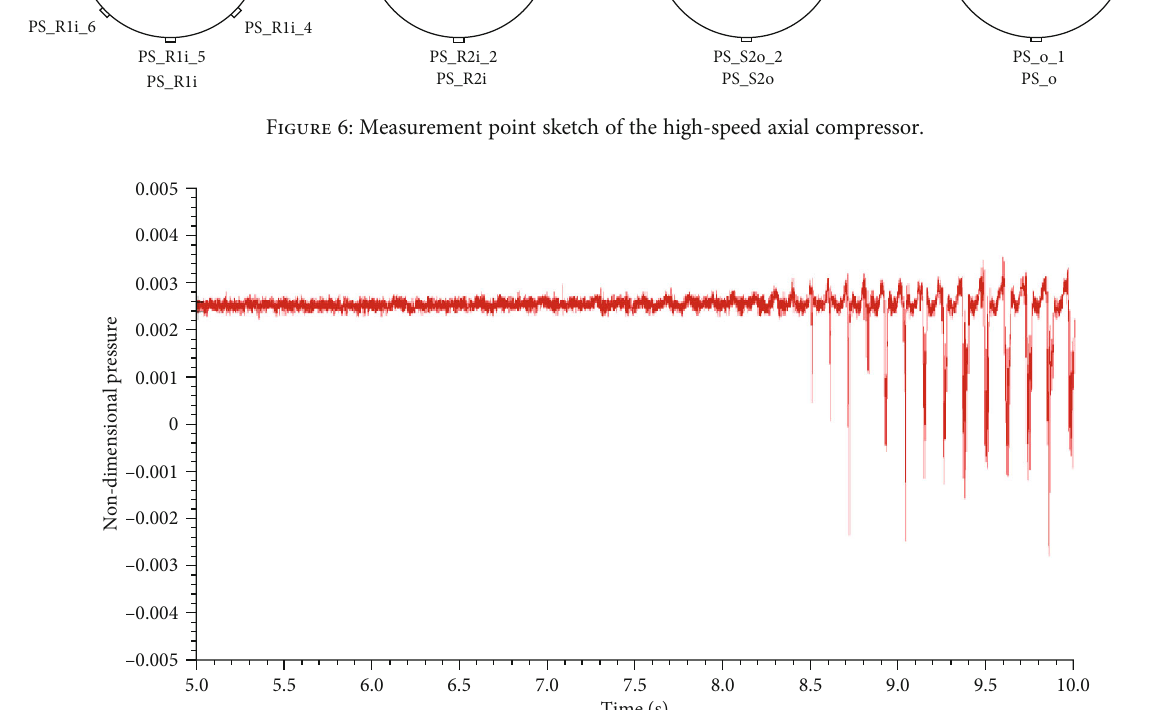
Figure 7: Time history of the dynamic total pressure output during the stall inception of the low-speed compressor.